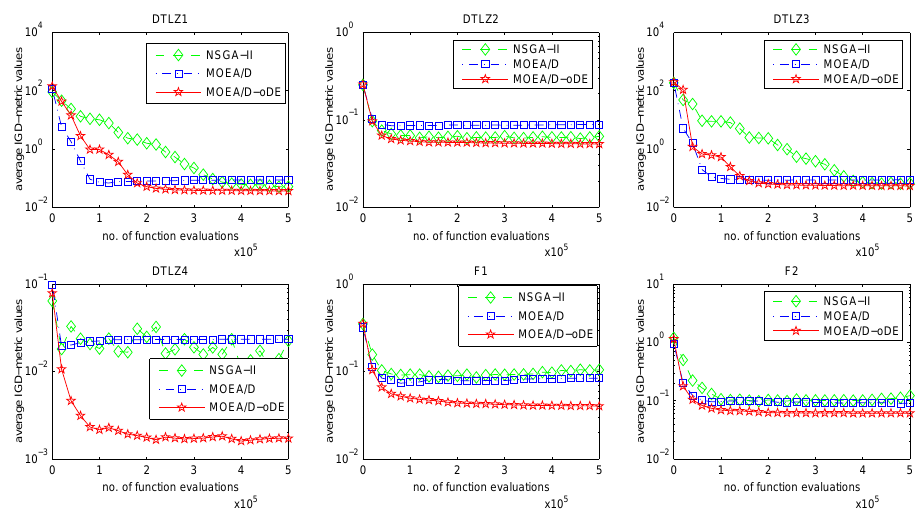
Figure 3. Evolution of the mean of IGD metric values for four-objective test problems.